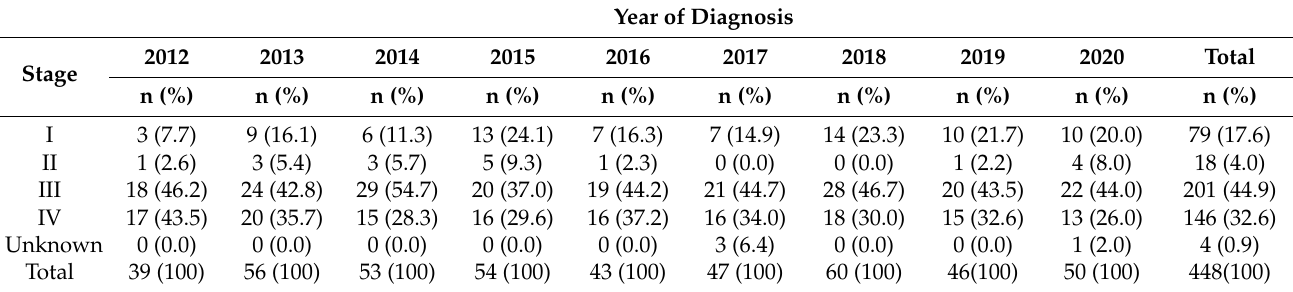
Table 2. Distribution of cases by stage and year of diagnosis.